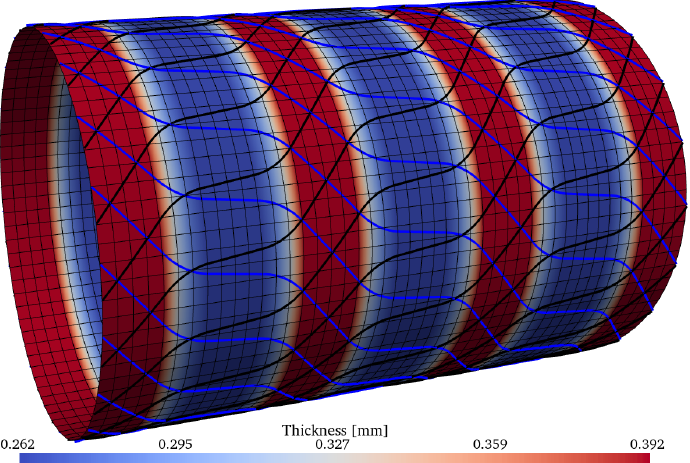
Figure 23. Optimum design ID = 1 from the Pareto front of Table 10, with m = 1.510 kg.